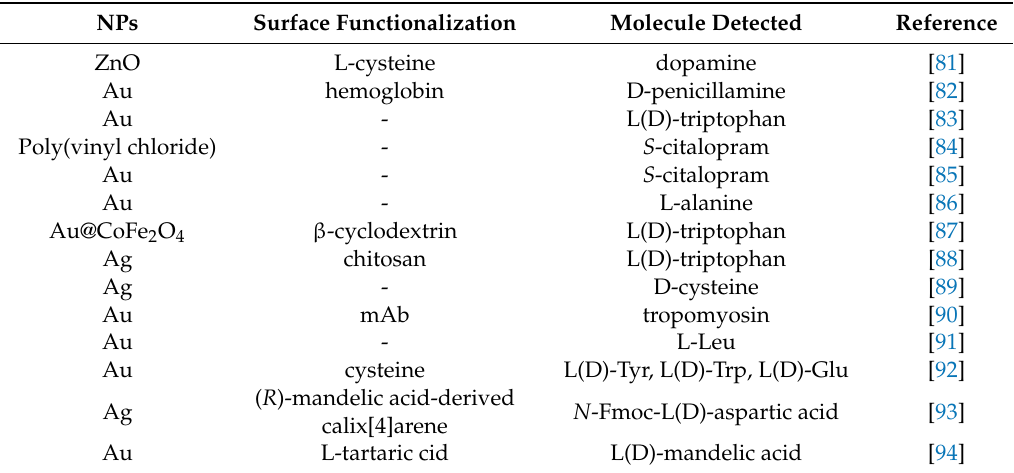
Table 4. Main applications of chiral NPs as biosensors and their principal